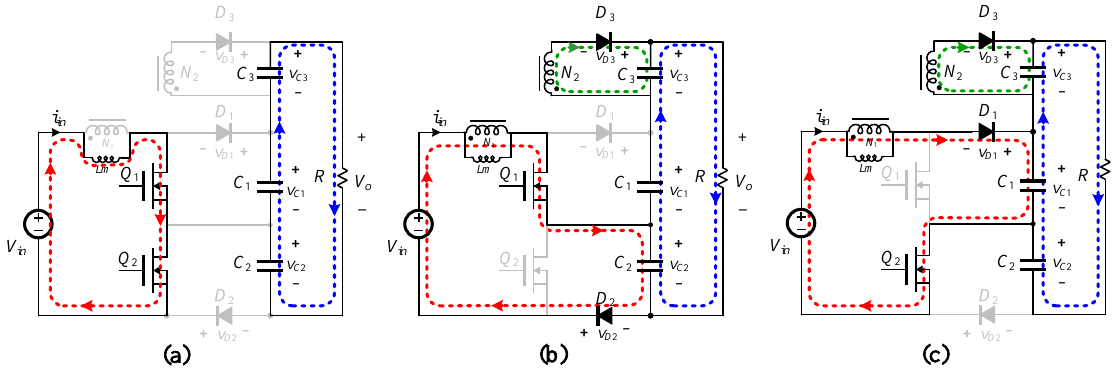
Figure 6. The equivalent circuit of the converter operating in: ( a ) Mode 1: both MOSFETs are conducting; ( b ) Mode 2: only Q 1 is conducting; and ( c ) Mode 3: only Q 2 is